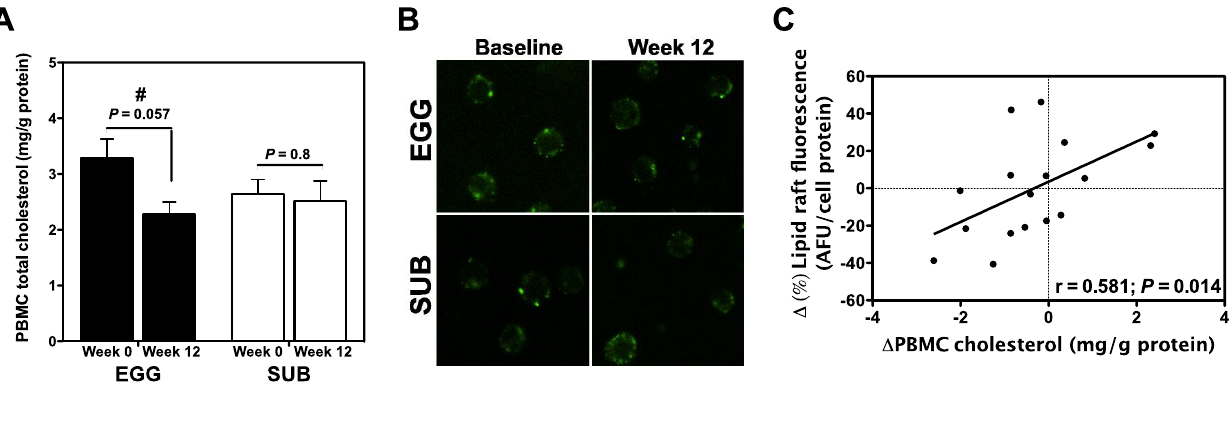
Figure 4. Effects of egg intake and carbohydrate restriction on PBMC cholesterol and lipid raft content. ( A ) PBMC cholesterol was measured by GC/MS and normalized to cell protein. Values are presented as mean ± SEM. # P = 0.057 for paired t test between baseline and week 12 in the EGG group. EGG: n = 15; SUB: n = 13; ( B ) PBMC lipid rafts were labeled with the Vybrant Alexa Fluor 488 Lipid Raft Labeling Kit (Molecular Probes, Eugene, OR, USA) and visualized using a Leica TCS SP2 Laser Scanning Confocal microscope (Leica Microsystems Inc., Buffalo Grove, IL, USA), 40× oil objective; ( C ) Relationship between percent changes in total lipid raft fluorescence (quantified by fluorescence plate reader) and PBMC cholesterol content as determined by Pearson